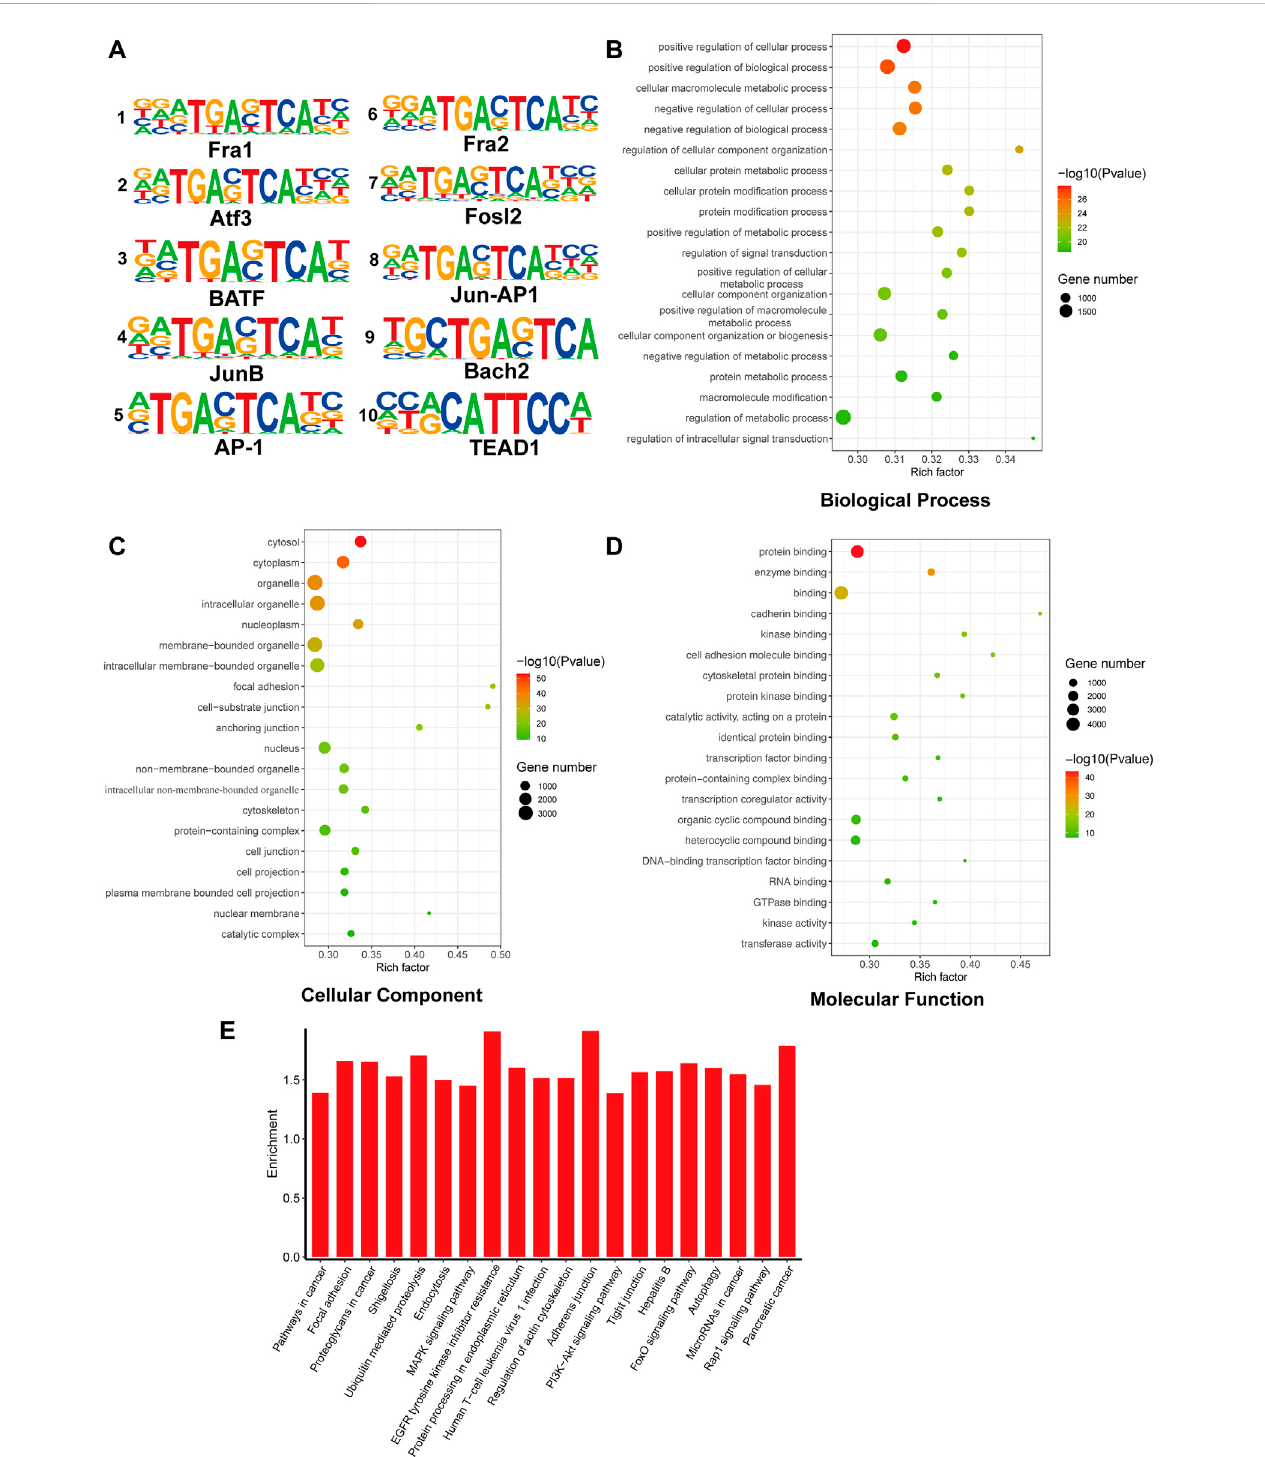
FIGURE 3 CUT&Tag seq analysis. (A) . The top 10 transcriptional factors binding to YAP. (B – D) . GO analysis of genes related to peaks. (E) . KEGG analysis of genes related to peaks.